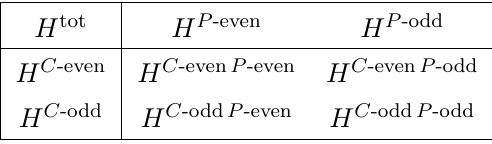
Table 7 . Hilbert series split up into transformations under C and P